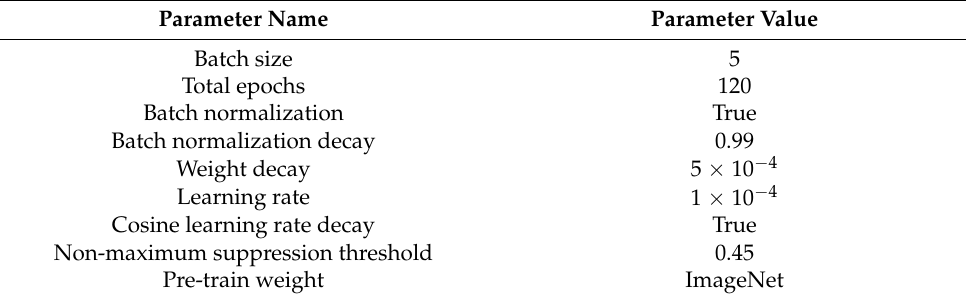
Table 5. YOLOv3 model training parameters.